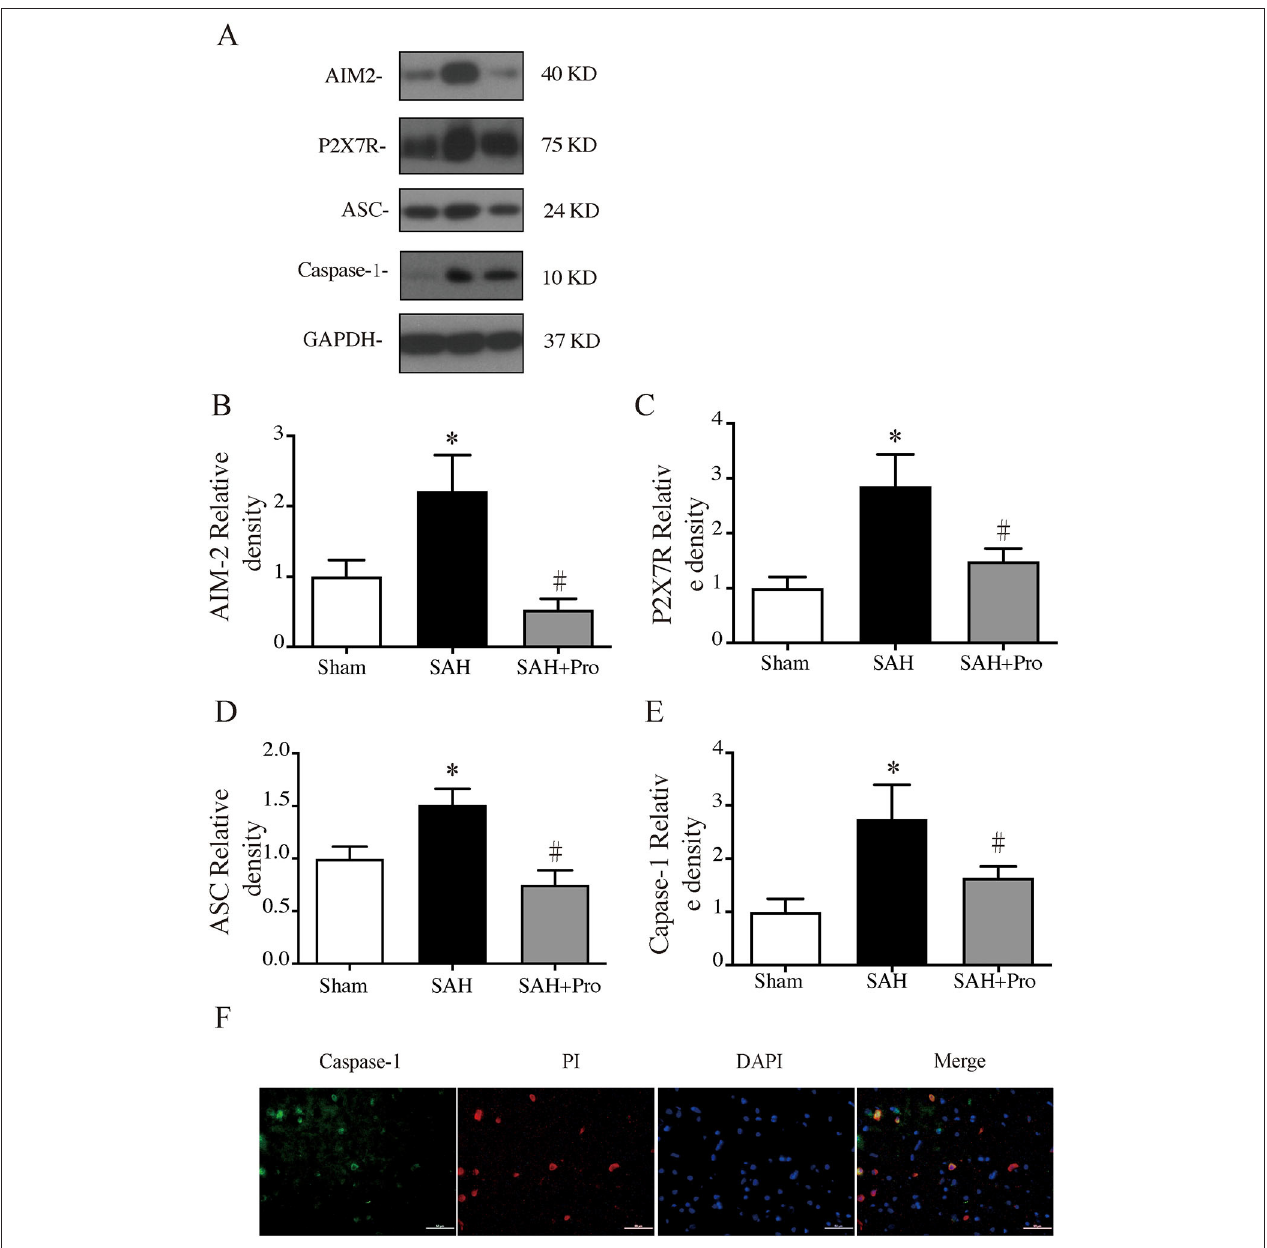
FIGURE 3 | (A) Representative western blotting images of AIM2, ATP-activated P2X7 purinergic receptor (P2X7R), apoptosis-associated speck-like proteins containing CARD (ASC), and caspase-1. (B) AIM2 protein levels in sham, SAH, and SAH + pro groups, n = 6 for each group. * p < 0.05 vs. sham group, # p < 0.05 vs. SAH group. (C) P2X7R protein levels in sham, SAH, and SAH + pro groups, n = 6 for each group. * p < 0.05 vs. sham group, # p < 0.05 vs. SAH group. (D) ASC protein levels in sham, SAHs and SAH + pro groups, n = 6 for each group. * p < 0.05 vs. sham group, # p < 0.05 vs. SAH group. (E) Caspase-1 protein levels in sham, SAH, and SAH + pro groups, n = 6 for each group. * p < 0.05 vs. sham group, # p < 0.05 vs. SAH group. (F) Representative micrographs showing double immunofluorescence labeling of caspase-1 with PI in the ipsilateral basal cortex at 24h after SAH. Scale bar = 50 µ m.